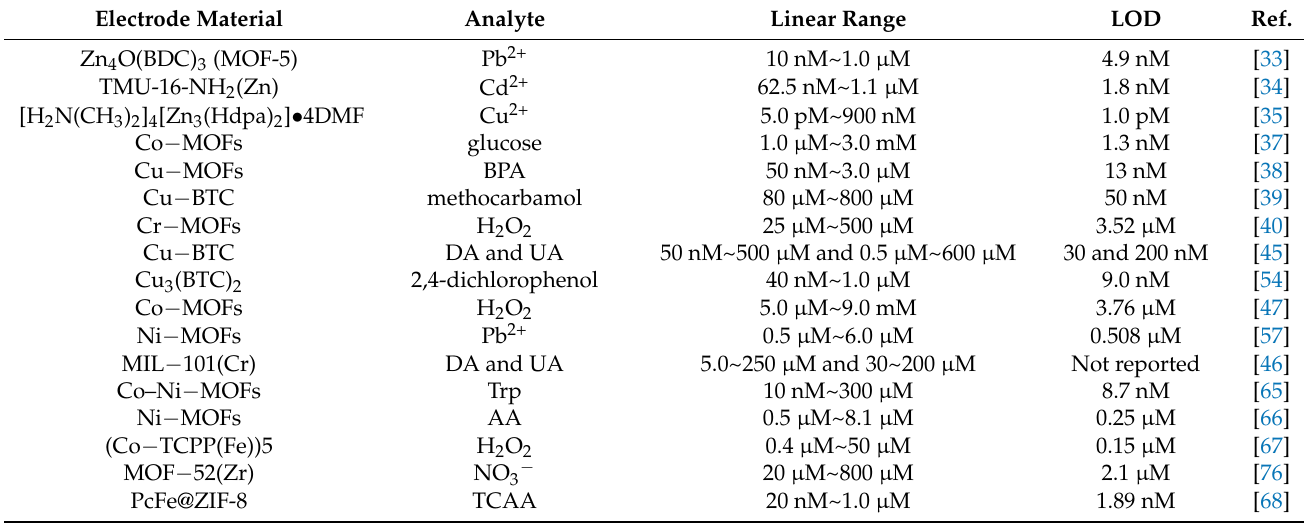
Table 1. Detection performances of pristine MOF − based electrochemical